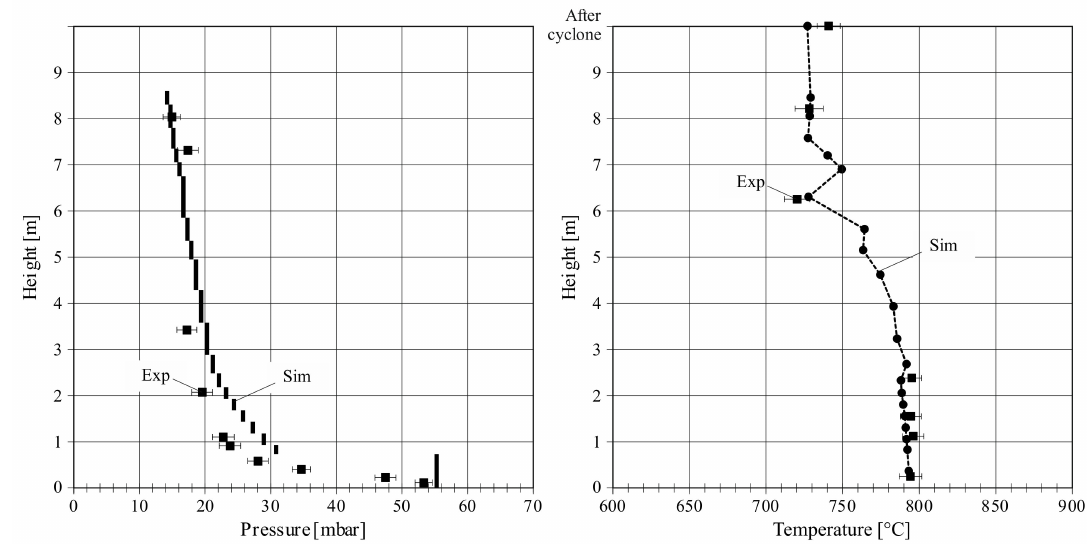
Figure 5. Pressure and temperature along with the reactor height (steady-state